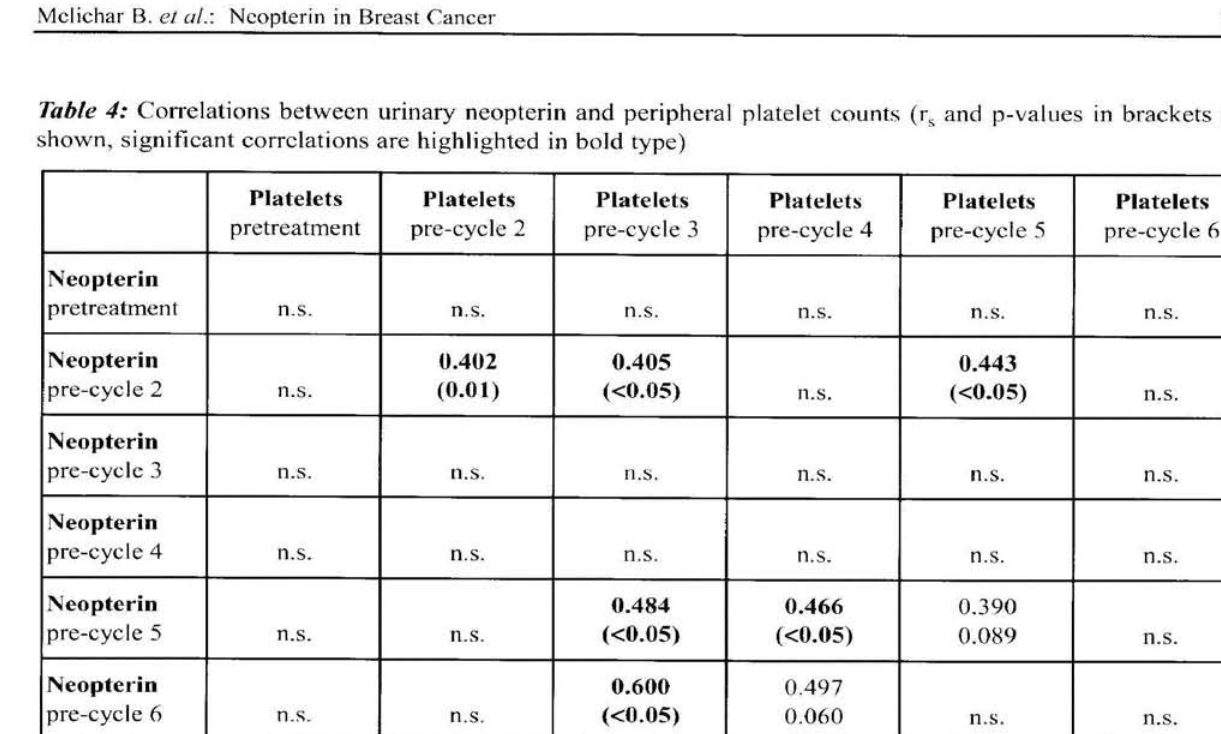
Table 4: Correlations between urinary neopterin and peripheral platelet counts (r s and p-values in brackets are shown, significant correlations are highlighted in bold type)